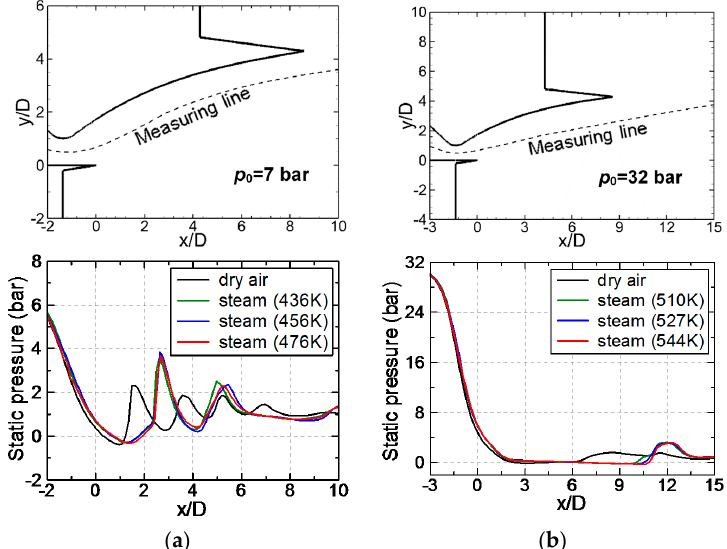
Figure 3. Distribution of static pressures along measuring line of asymmetric nozzle. ( a ) p 0 = 7 bar; and ( b ) p 0 = 32 bar.